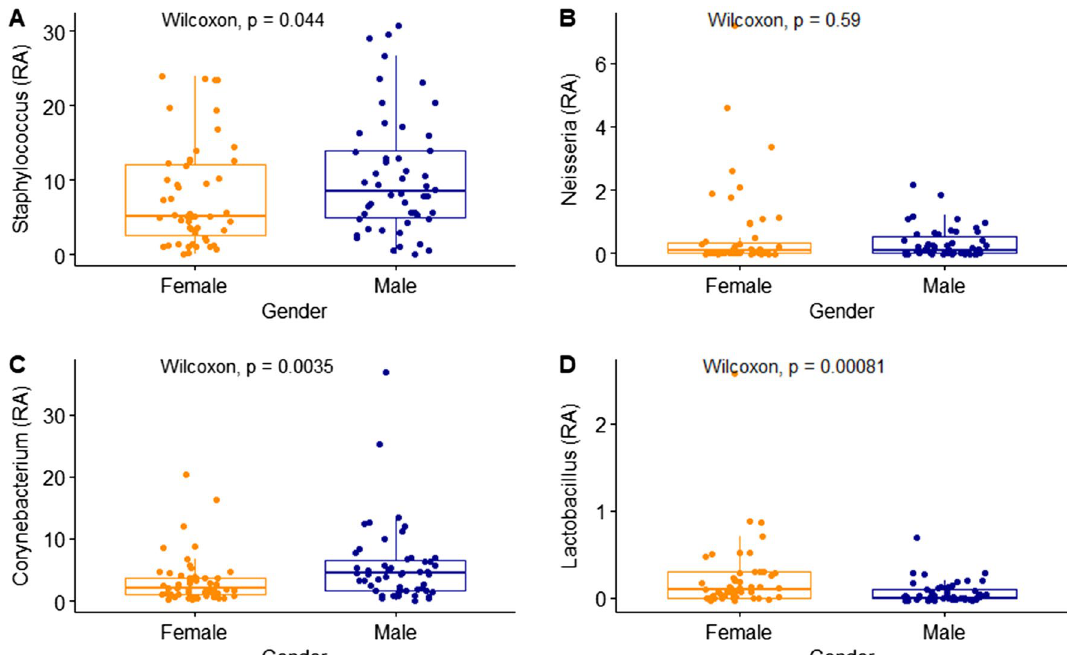
Figure 6. Relative abundance (%) of four genera in skin samples between female and male. ( A ) Staphylococcus ; ( B ) Neisseria ; ( C ) Corynebacterium ; ( D ) Lactobacillus . Wilcoxon signed-rank test was used for statistical analysis. P values are displayed in the